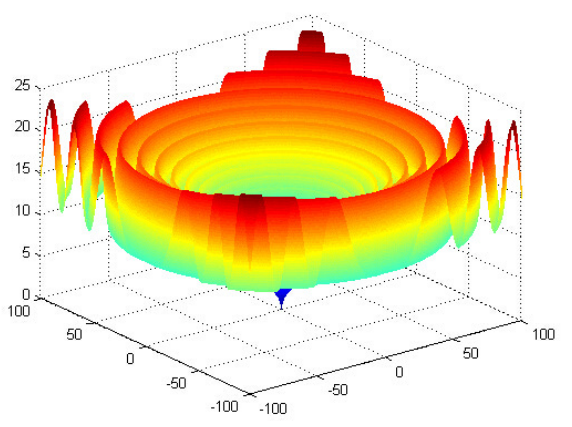
Figure 8. The graph of function F 4